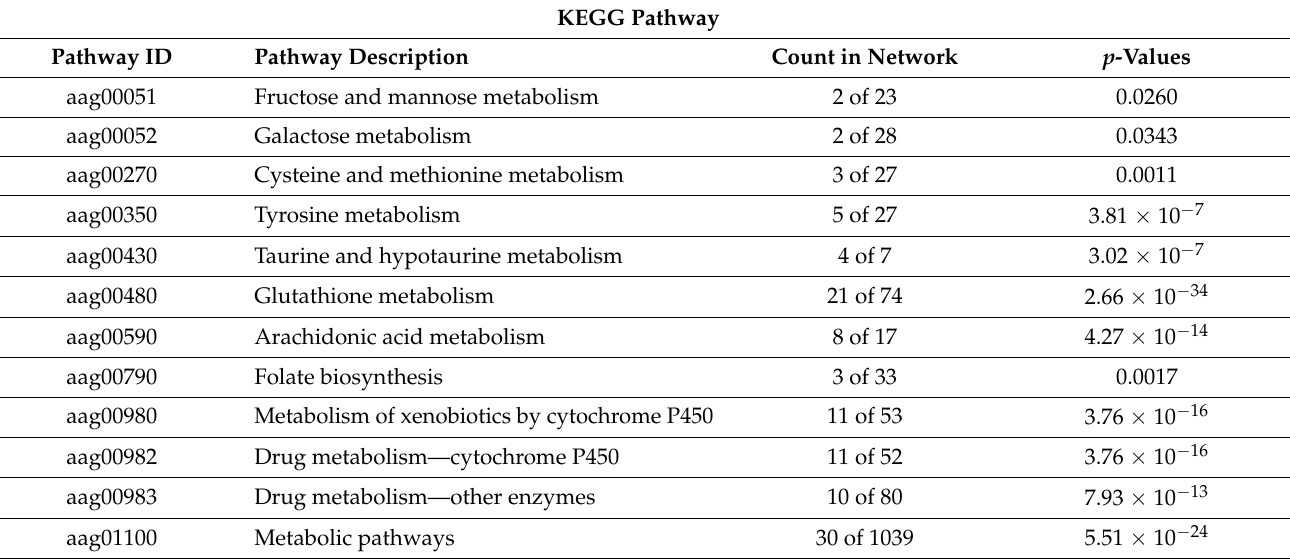
Table 4. Characteristics of KEGG pathways of protein-protein interaction of GSTs with STRING